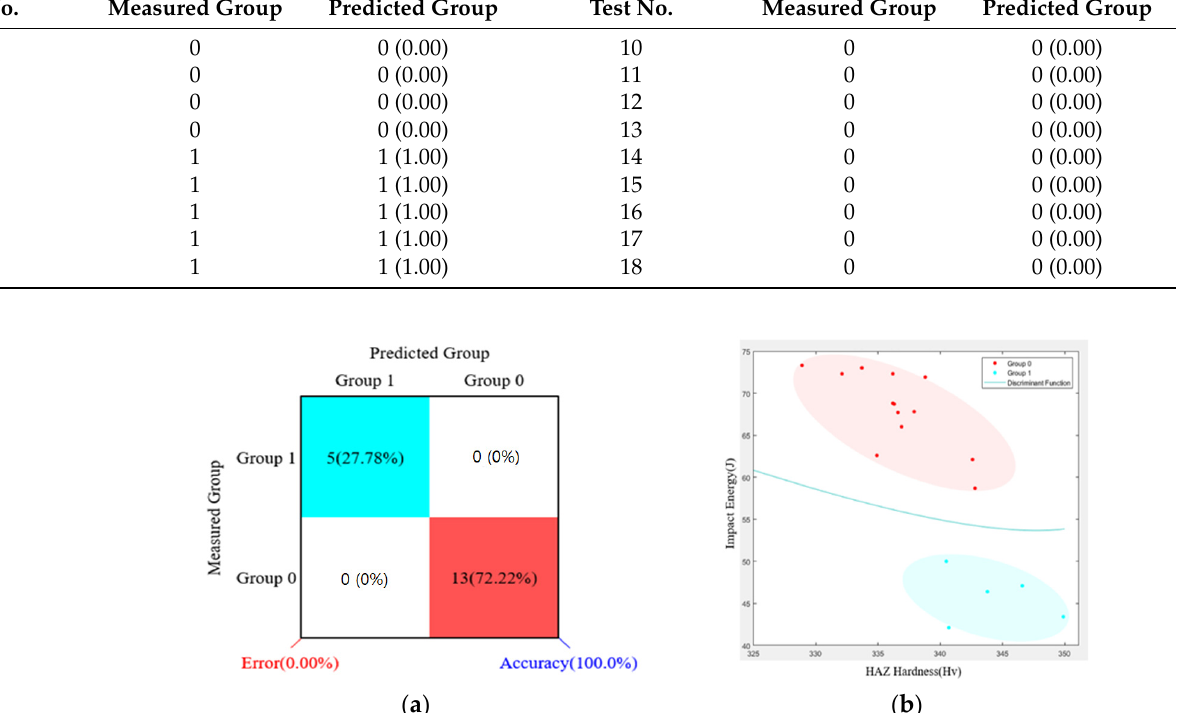
Figure 8. Brittle fracture behavior discriminant in flux core arc welding: ( a ) performance evaluation for SVM and ( b ) discriminant graph for SVM.